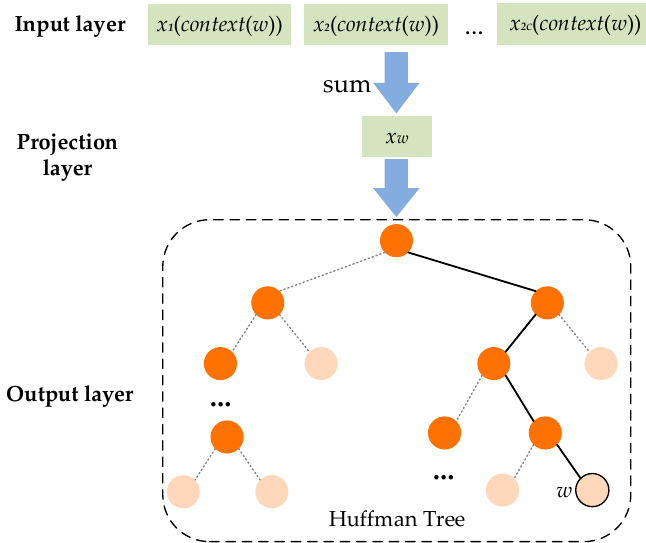
Figure 3. Training framework based on continuous bag-of-words (CBOW) model.